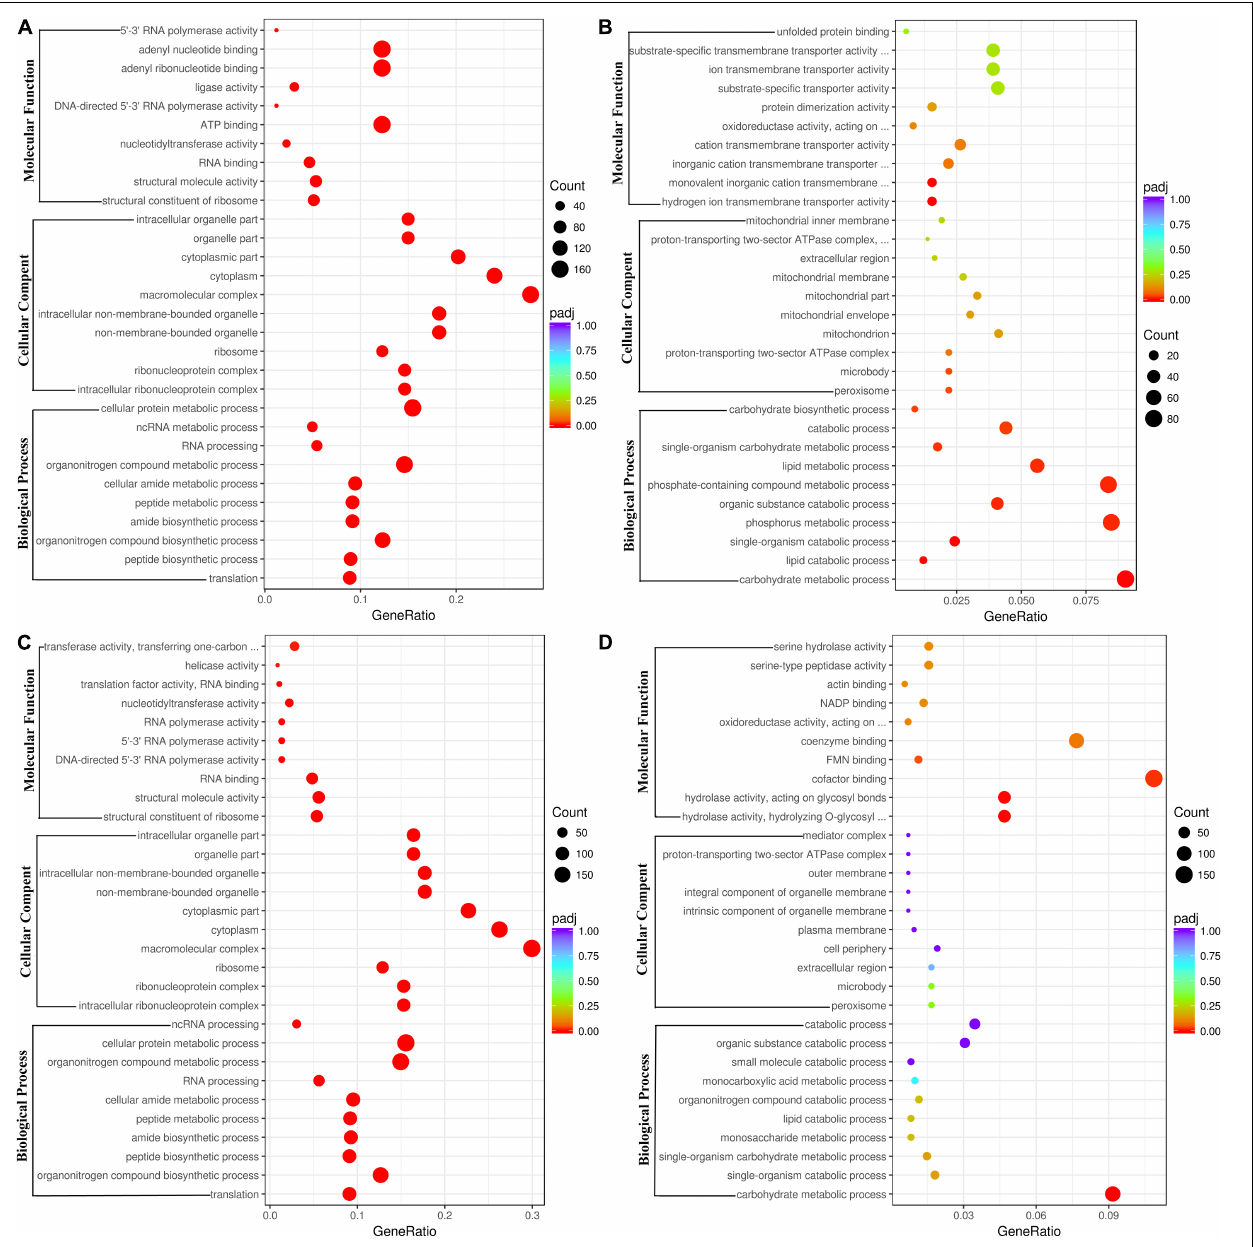
FIGURE 2 | Go functional classification of down-regulated (A,C) and up-regulated (B,D) DEGs. (A,B) The ordinate means with 2.5% ethanol treatment. (C,D) The ordinate means with 3.5% ethanol treatment. The size of the plot represents the number of DEGs in one GO term; the color of the plot close to red represents more significant